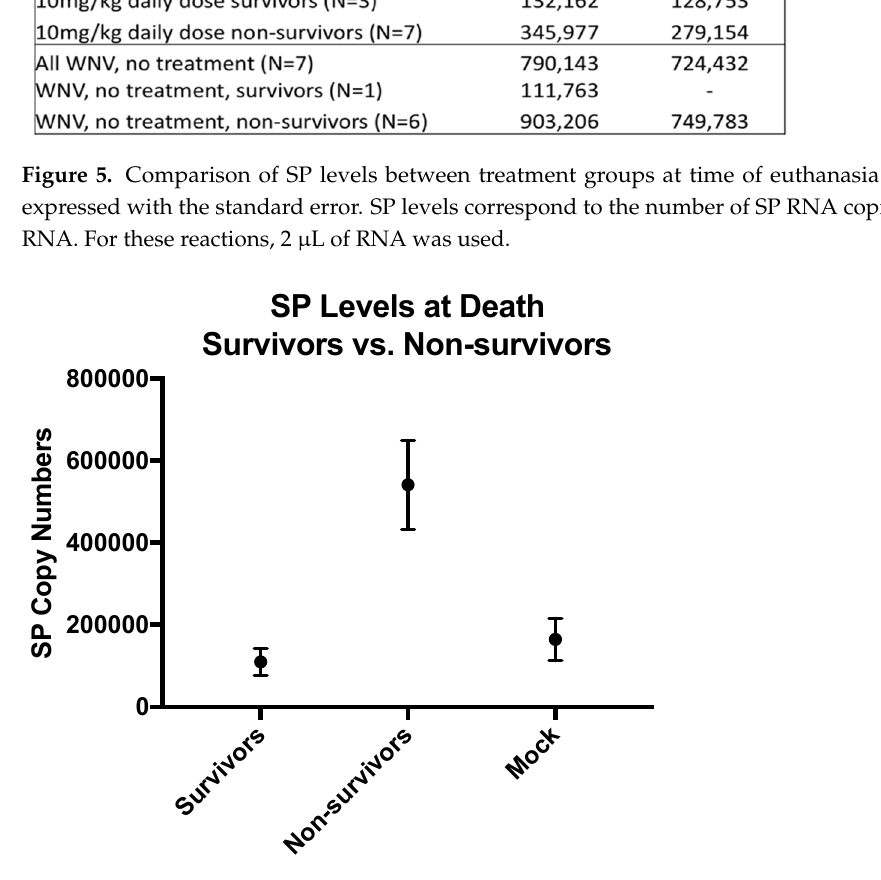
Figure 5. Comparison of SP levels between treatment groups at time of euthanasia. Means are ex- pressed with the standard error. SP levels correspond to the number of SP RNA copies per µL of RNA. For these reactions, 2 µL of RNA was used.